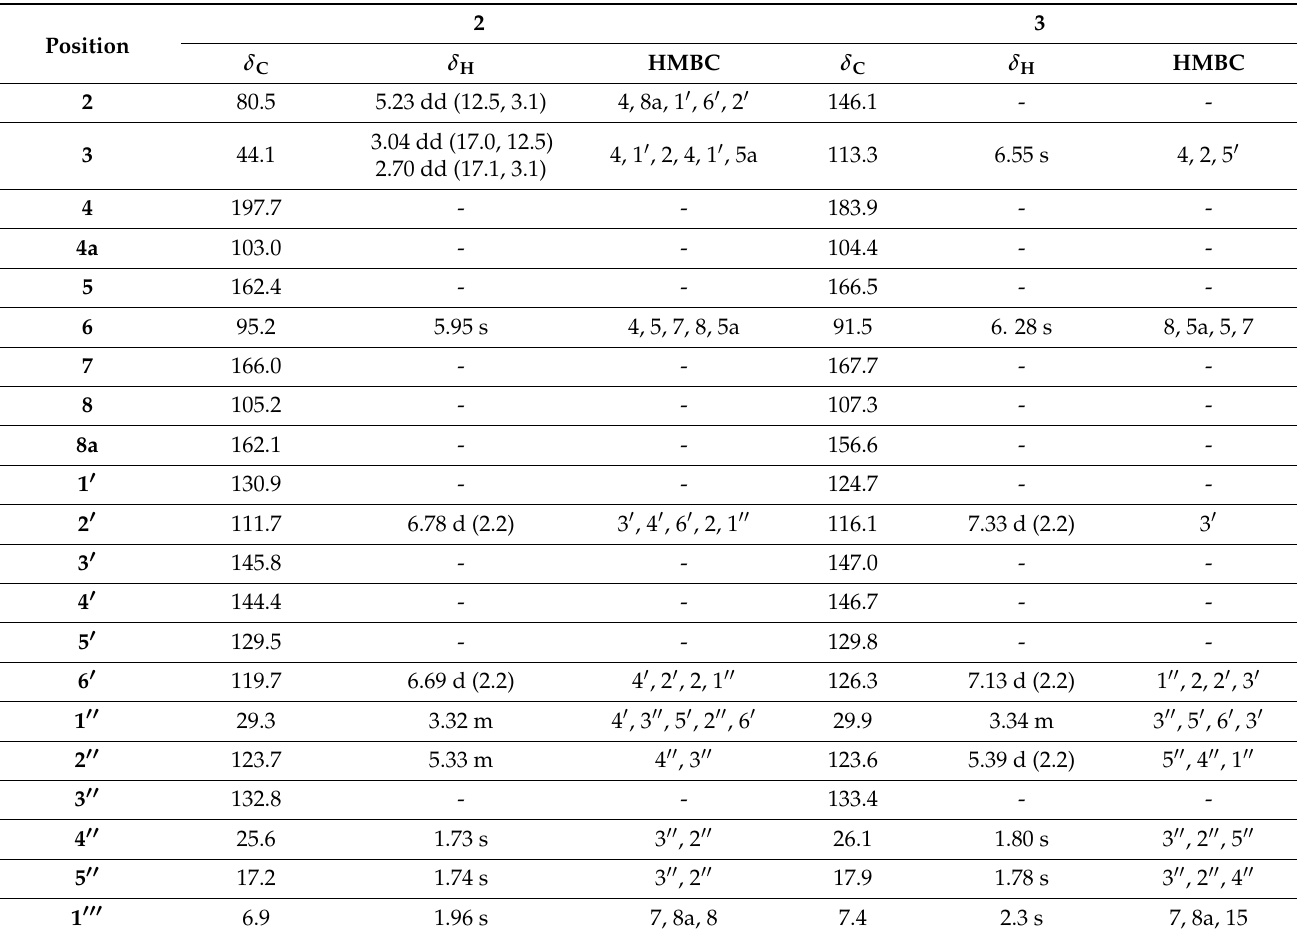
Table 2. 1 H- (500 MHz) and 13 C-NMR (125 MHz) data of 2 and 3 in CD 3